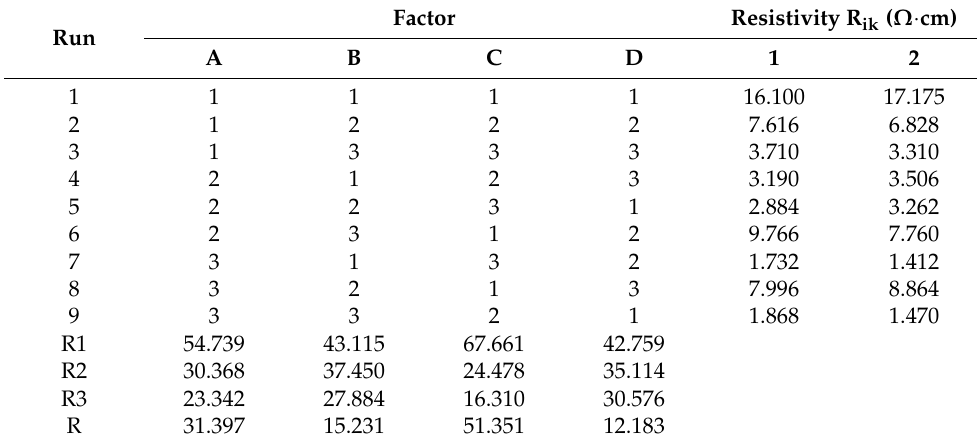
Table 3. Range analysis of experiment